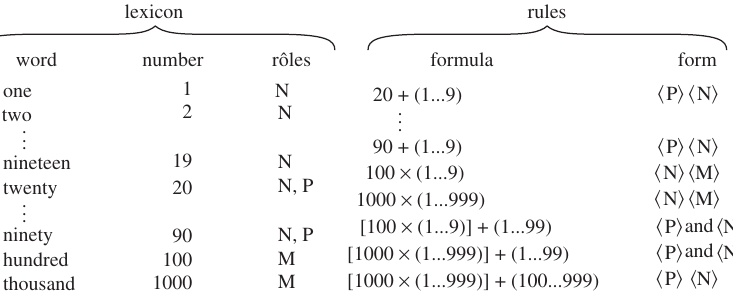
Figure 1: The English Numeral System for Numbers up to